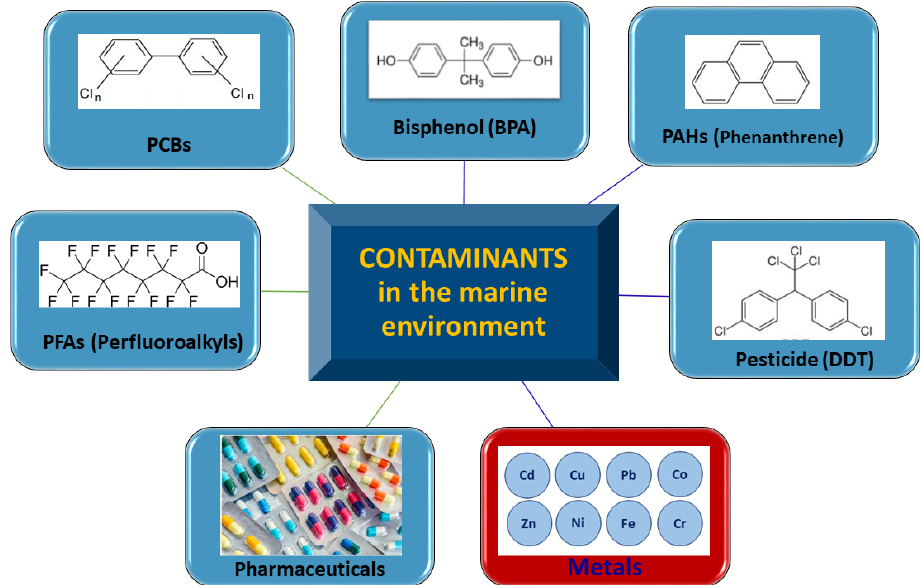
Figure 1. The most common contaminants present in the microplastics in the marine environment. Polychlorinated biphenyls (PCBs) are a wide group of organochlorine compounds